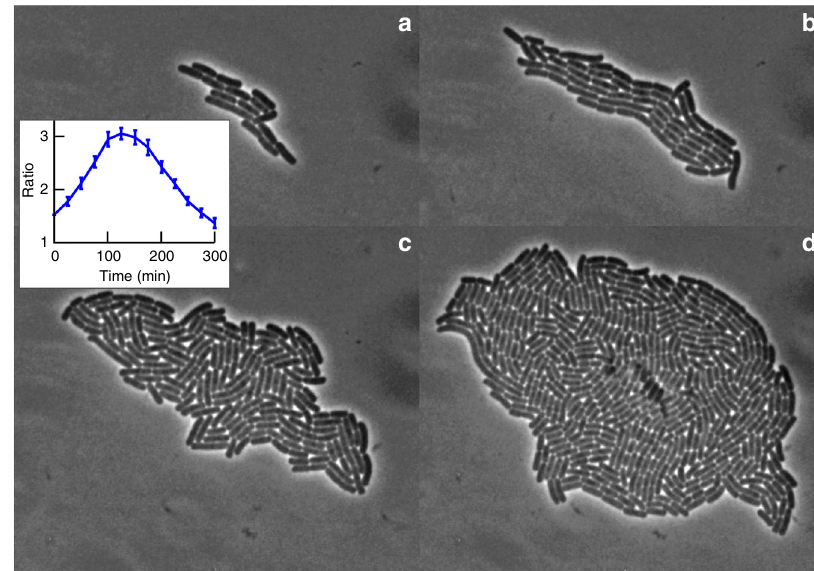
Fig. 1 Morphology of a growing bacterial colony. Snapshots of a growing colony, from a few cells ( a ; t = 125 min, N = 15), through the early stages of growth where the colony elongates ( b ; t = 171 min, N = 56), followed by later stages of growth in which the colony shape becomes less anisotropic ( c ; t = 216 min, N = 164), up to the time immediately prior to the colony invading the third dimension ( d ; t = 261 min, N = 475). Inset: The average ratio of long and short axes of 32 colonies plotted against time. The axes are estimated as the square roots of the larger and smaller eigenvalue of the second moment of area. Error bars are standard errors of the mean